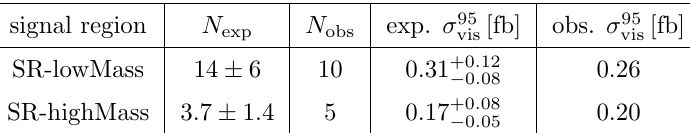
Table 2 . 95% CL limits on the non-SM cross section for the di-tau + (cid:26)(cid:26) E T